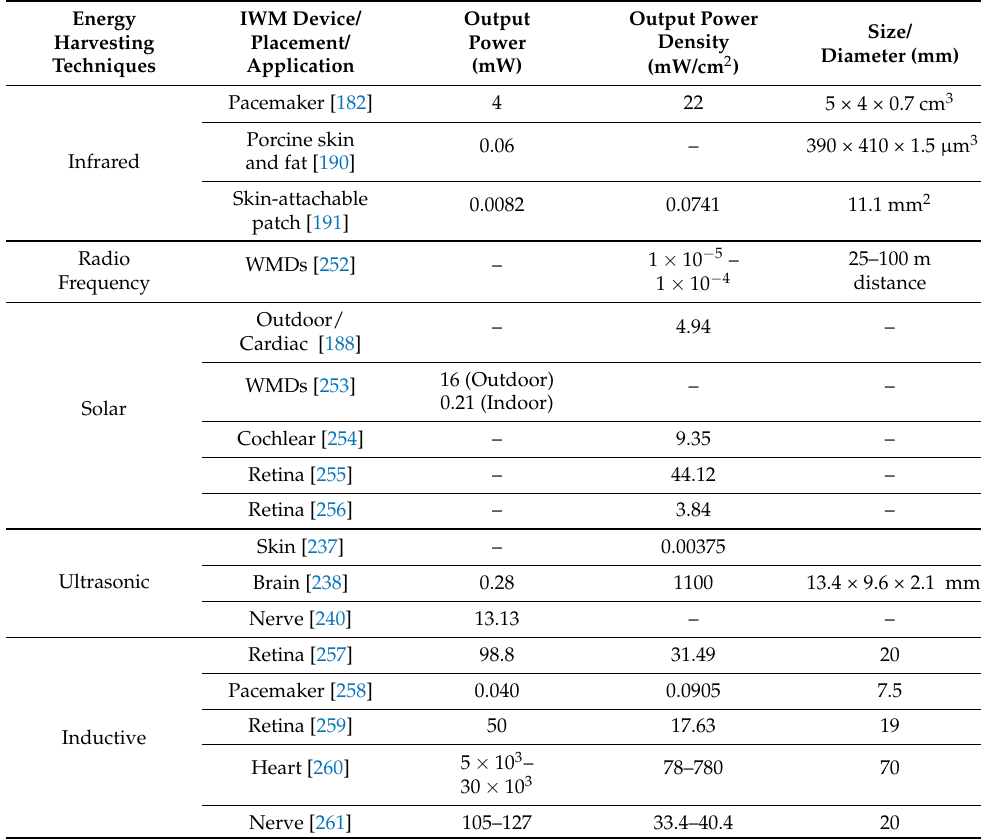
Table 2. Summary of representative works on environment-centric energy harvesting techniques. Energy